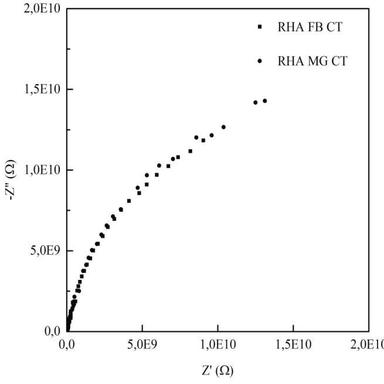
Nyquist diagrams of the silica samples obtained by the chemical method of RHA FB and MG.